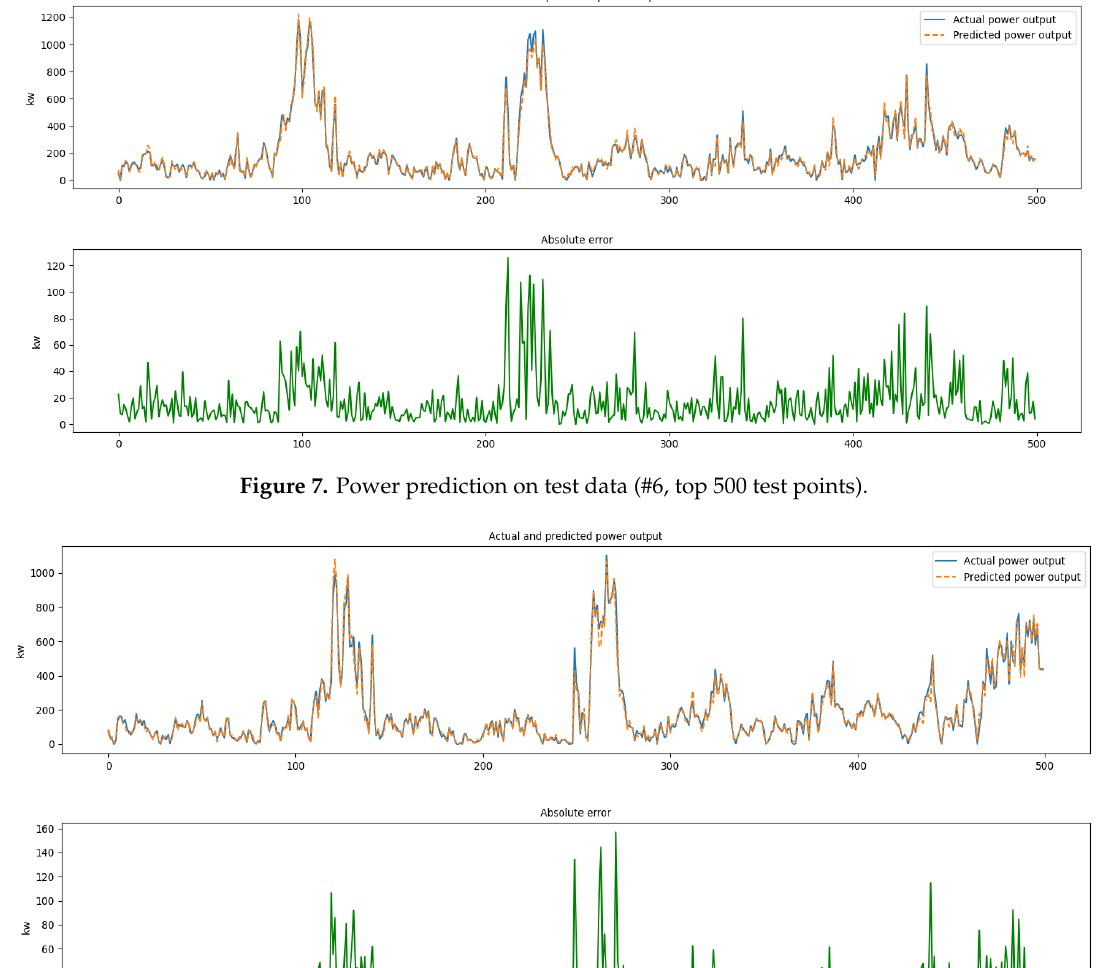
Table 5. Performances of stacking model on test data.